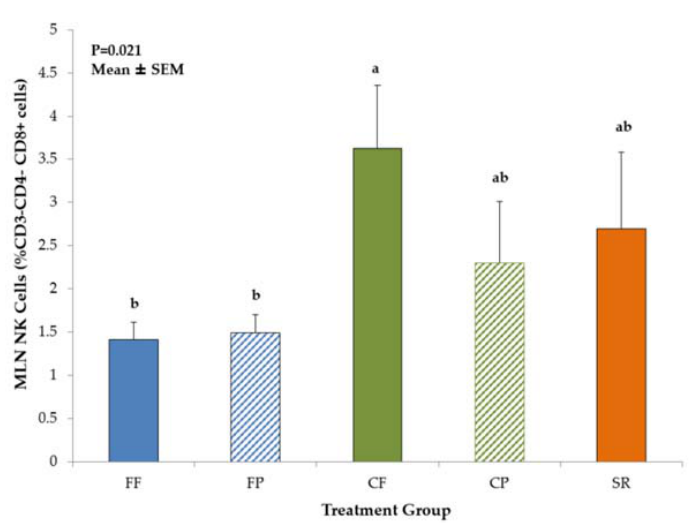
Figure 5. Natural Killer Cells in MLN of 21-day-old piglets fed different diets. The CF group had significantly higher population of NK cells compared to both FF and FP groups with both CP and SR being intermediate. Values are mean ± SEM. Bars with different superscripts (e.g., a vs. b) indicate statistical significance at p < 0.05. Abbreviations: FF, formula-fed ( n = 10); FP, formula+prebiotic ( n = 10); CF, combination-fed ( n = 8); CP combination-fed+prebiotic ( n = 7); SR, sow-reared ( n =